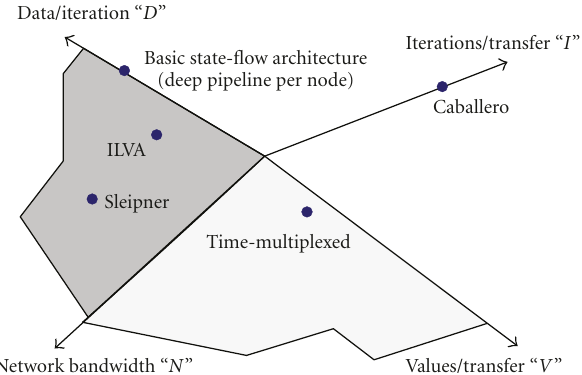
Figure 5: A 4-dimensional design space { V , I , N , D } of CNN